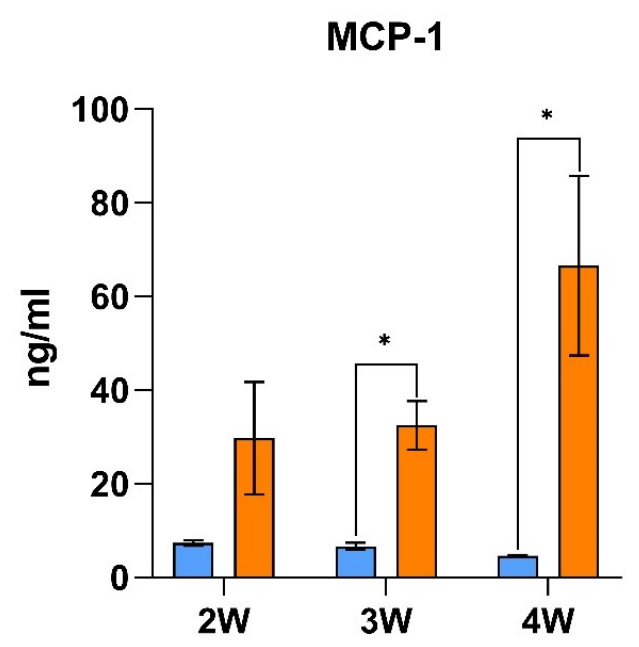
Figure 1. Assessment of inflammation levels during the experimental period by MCP-1 monitoring. The results are presented as the mean ± SEM ( n = 10 animals per group). * indicates significant differences using t -student test between CON and LPS group ( p < 0.05). Abbreviations: MCP-1, monocyte chemoattractant protein-1; W, study’s week. Table 1. Characteristics of the LPS-induced inflammation model. The results are presented as the mean ± SEM ( n = 10 animals per group). The biometric parameters are represented as a ratio (g/kg BW × 100) to properly compare the parameters. The statistical comparisons among groups were conducted using t -student test, and fold change (FC) was calculated (LPS/CON). * p < 0.05 (significantly different) and ** p < 0.01 (high significantly different) compared with control. BW, body weight; RWAT, retroperitoneal white adipose tissue; MWAT, mesenteric white adipose tissue; MCP-1, monocyte chemoattractant protein-1; IL-6, interleukin-6; PGE2, prostaglandin E2; TNF- α , tumour necrosis factor alpha; TG, triglycerides; TC, total cholesterol; NEFAs, non-esterified fatty acids.